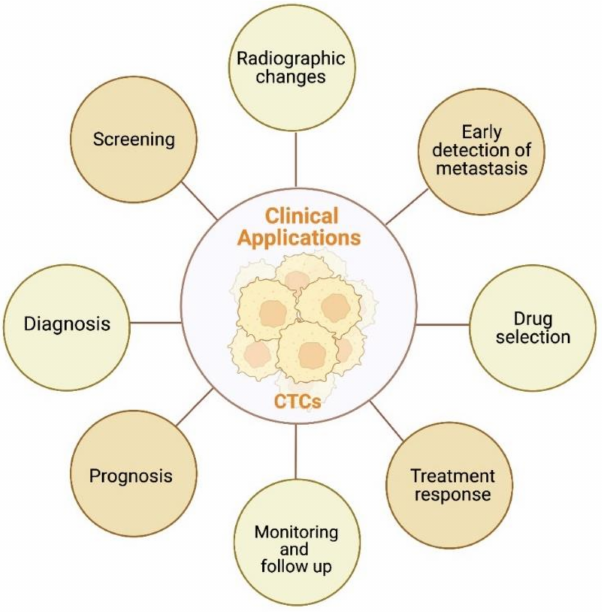
Figure 3. Schematic representation of potential clinical applications of CTCs in RCC. Created with